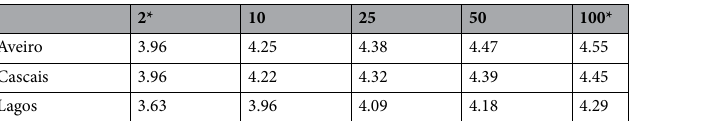
Table 1. Extreme sea levels (m) relative to Chart Datum. The asterisk represents the return periods considered in flood modeling.